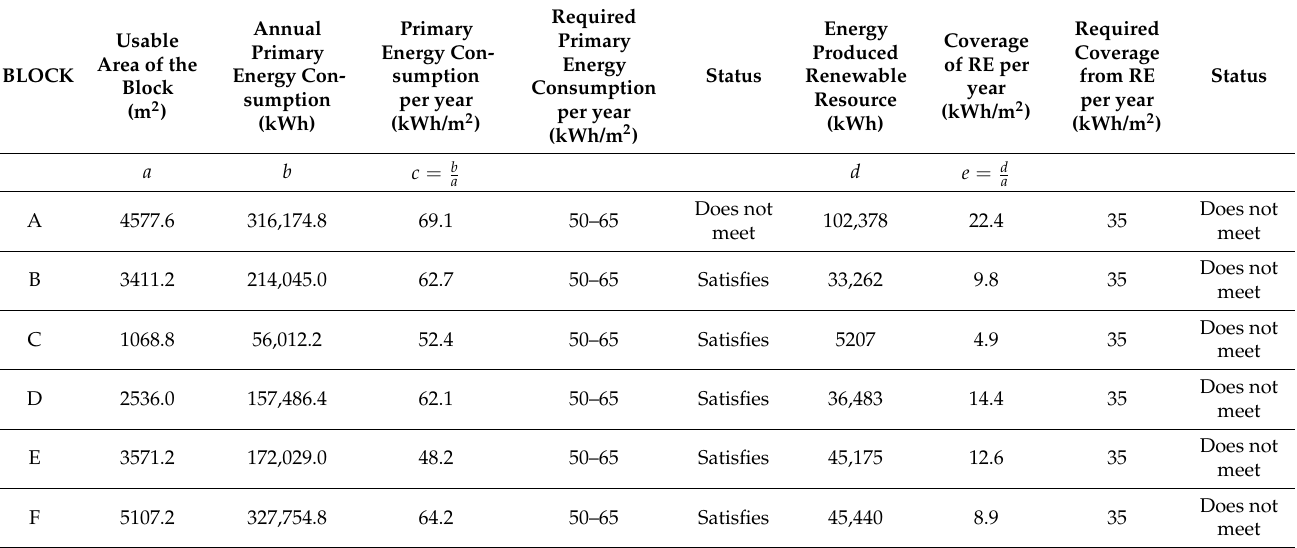
Table 16. Primary energy consumption and RE coverage for the state after